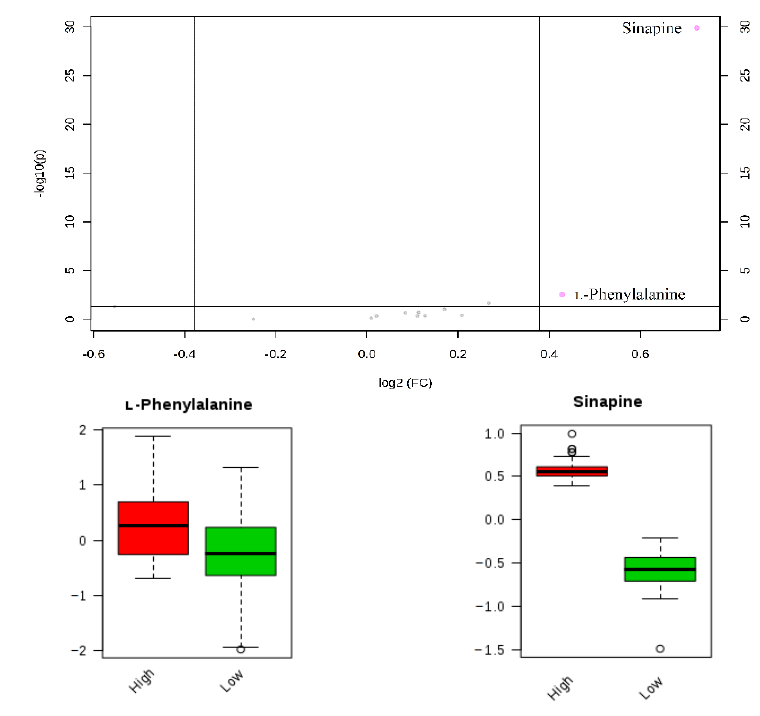
Figure 5. Volcano plot of phenolic compounds and box-plot of differential compounds.